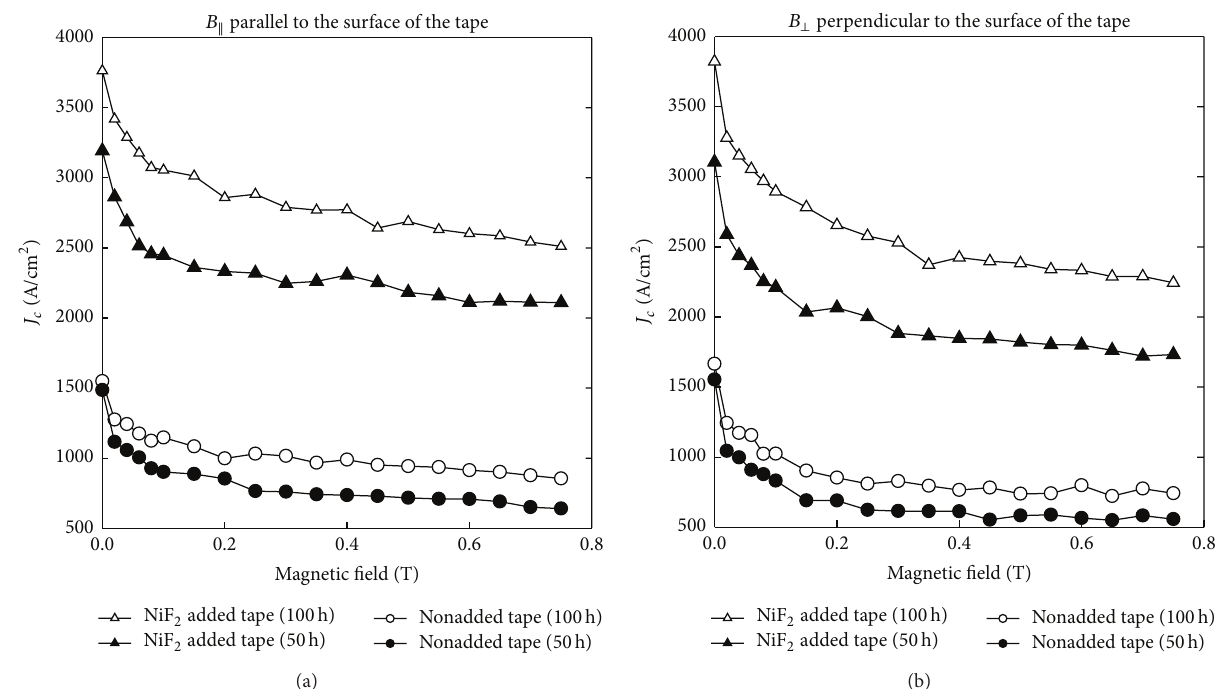
Figure 5: Magnetic field dependence of critical current density, 𝐽 𝑐 , at 77K for nonadded and NiF 2 added Bi-2223 tapes sintered for 50 and